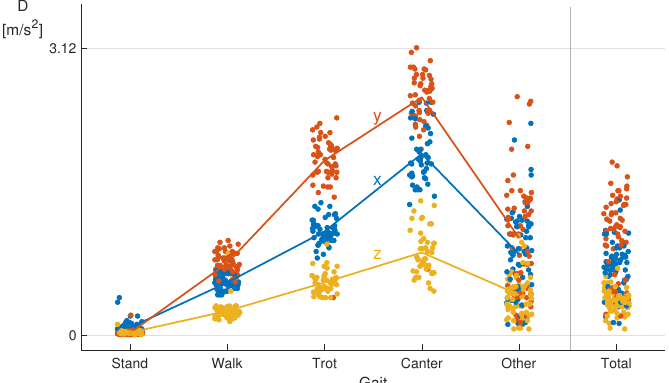
Figure 6. Average absolute deviation D (m/s 2 ) for different gaits for all datasets, the y-direction (orange) has the highest average absolute deviation compared to x (blue) and z (yellow) directions. For the higher energetic gaits, the spread over the different datasets is